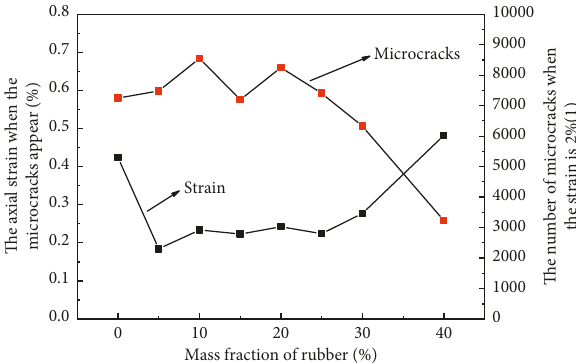
0.0 0.2 0.4 0.6 0.8 1.0 1.2 1.4 1.6 1.8